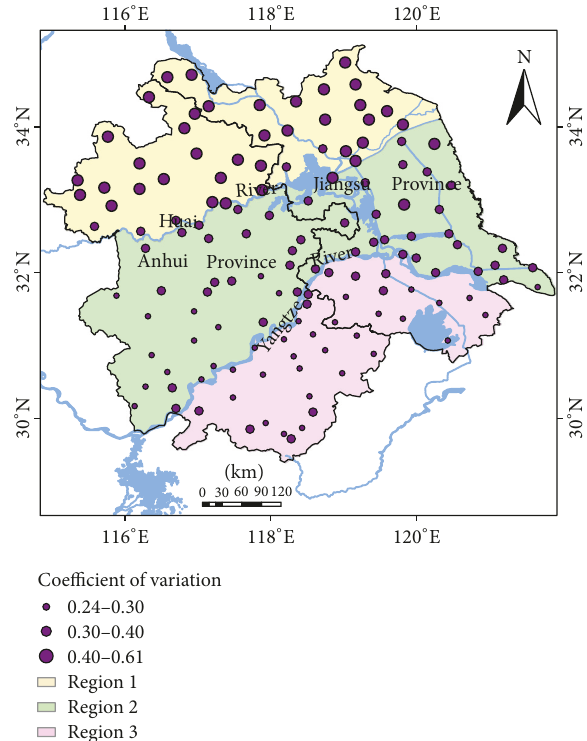
Figure 2: Spatial distribution of the coefficient of variation of spring precipitation from 1971 to